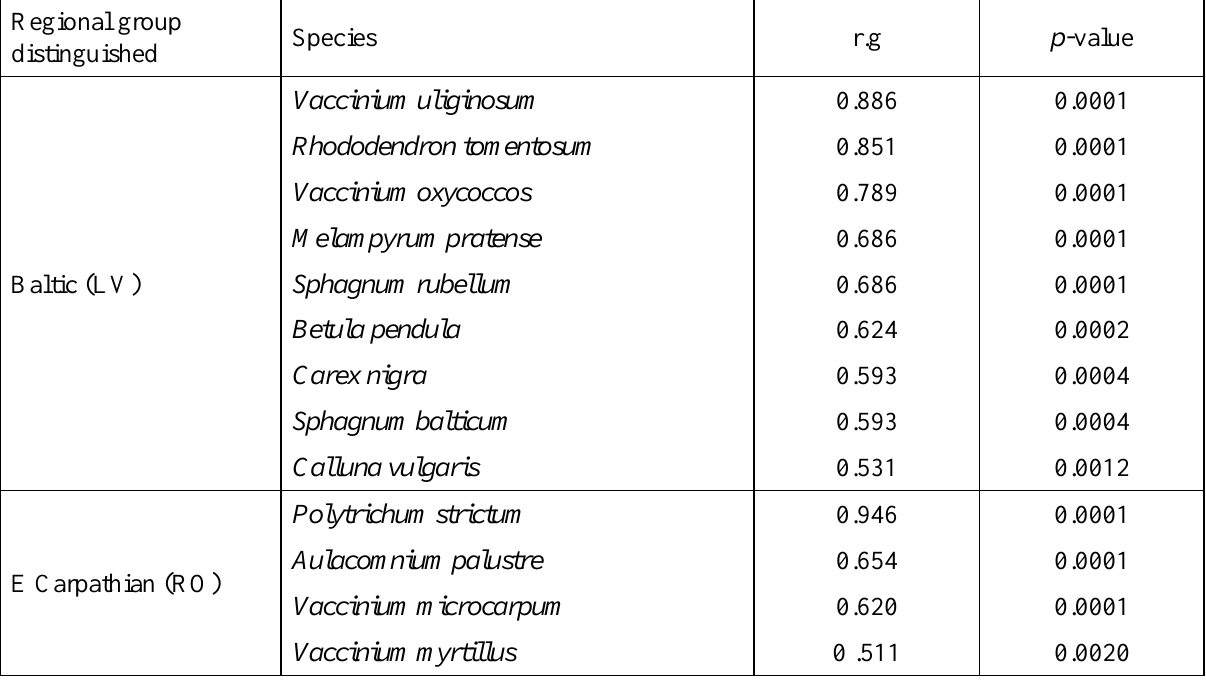
Table 1. Group-equalised phi coefficient (r.g.) of correlation between each species and the associated regional group of relevés (either Baltic or Eastern Carpathian). Only species displaying r.g larger than 0.5 in the paired group analysis are